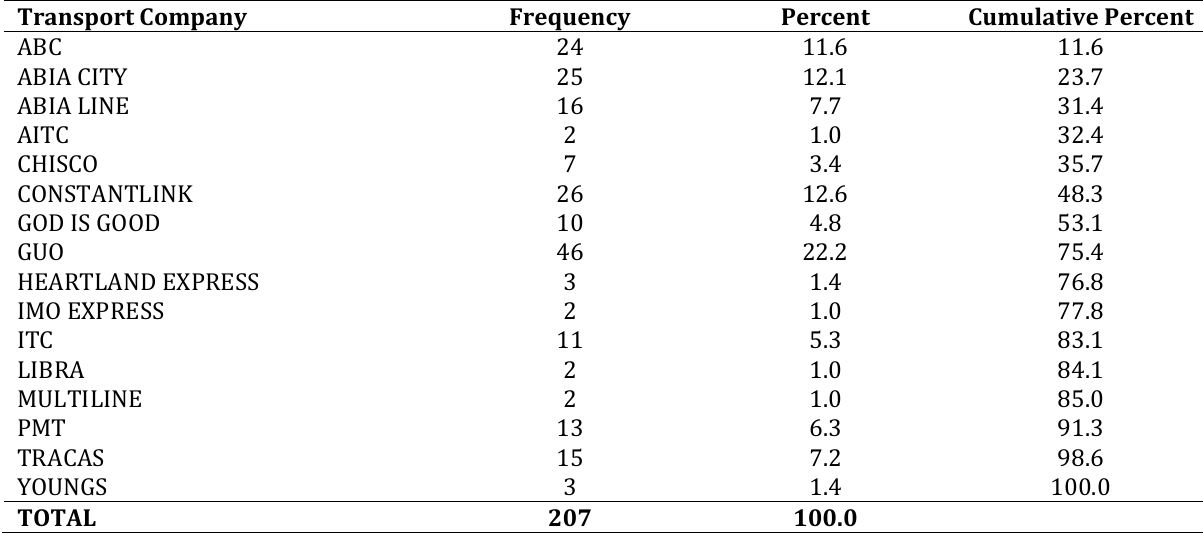
Table 1: Urban Transport Companies Surveyed Transport